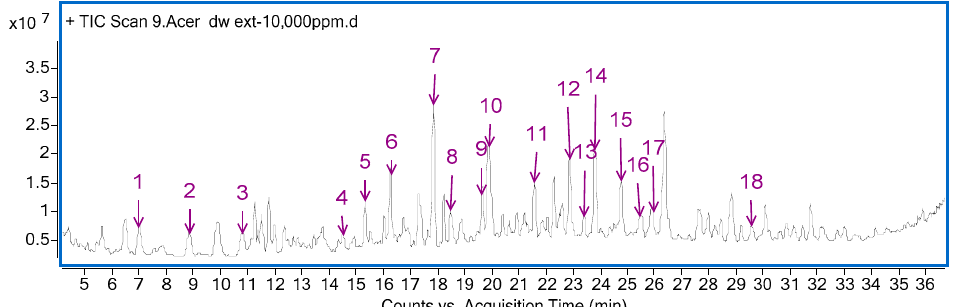
Figure 5. A representative chromatogram in a hydrothermal extract of A. tegmentosum by Q-TOF-MS. Figure 6. A representative chromatogram in a hydrothermal extract of A. tegmentosum by 3.5. Antioxidant Activities of A. tegmentosum Extract in HepG2 Cells